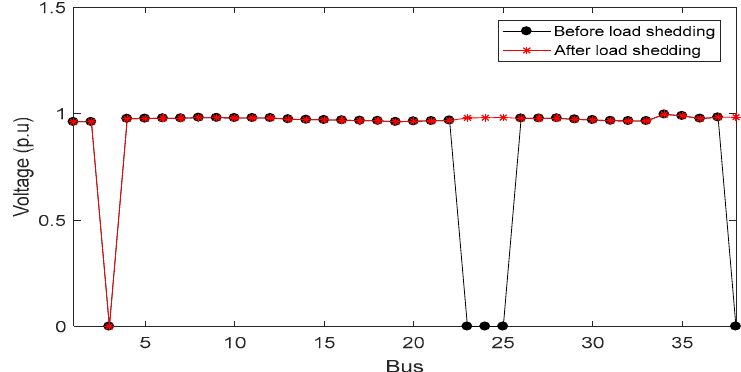
Figure 8. Bus voltages at faulted bus #3 prior to and after load shedding.